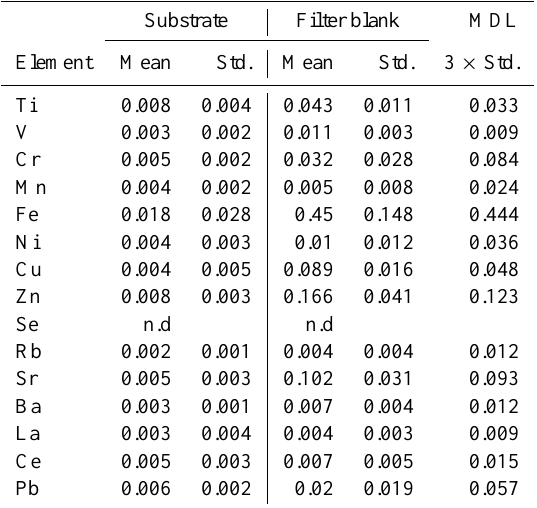
Table 1. Average blank values of quartz substrate ( n = 75) and fil- ter blank ( n = 20) and overall method detection limit (MDL). All values are given in ng. Typical sampled volume was 105 m 3 . n.d. implies not